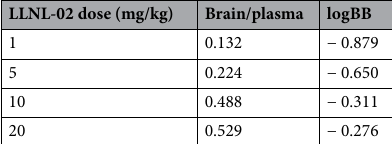
Table 3. Brain-plasma ratio of LLNL-02 ( 1 ) at T max following a single IV dose of 14 C-LLNL-02 to male guinea